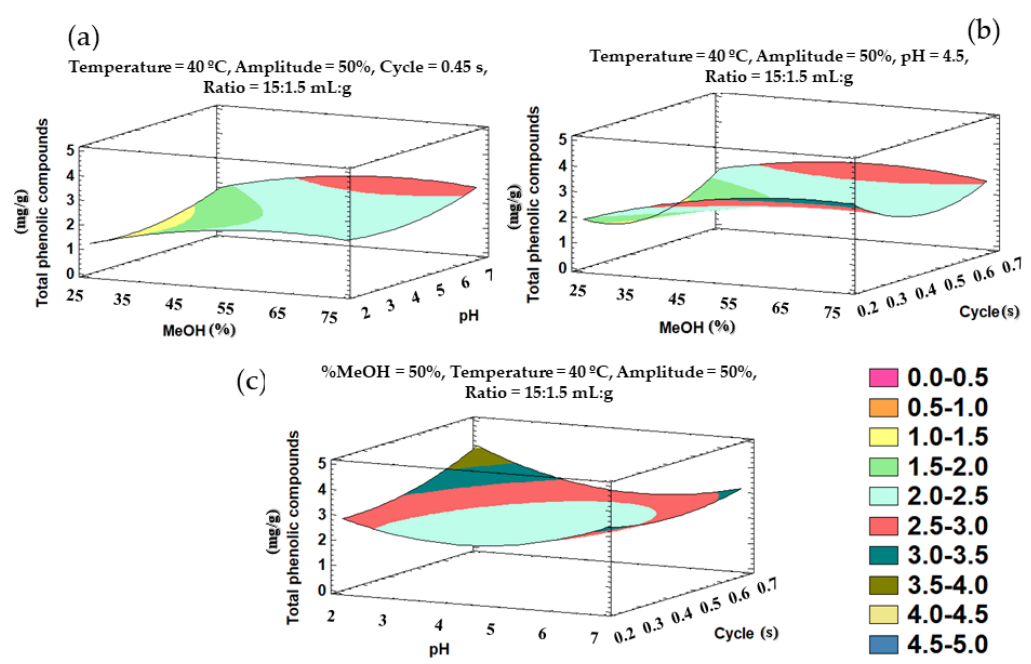
Figure 4. Three-dimensional surface plots representing the recovery of phenolic compounds according to a Box–Behnken design and depending on the following influential variables on the total phenolic compounds: ( a ) % methanol in water and pH; ( b ) % methanol in water and cycle; ( c ) pH and cycle.